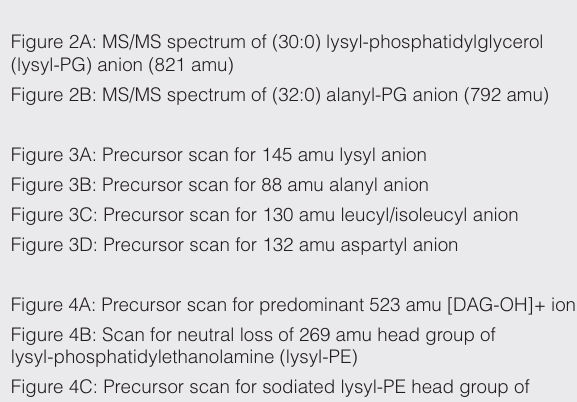
Figure 2A: MS/MS spectrum of (30:0) lysyl-phosphatidylglycerol (lysyl-PG) anion (821 amu) Figure 2B: MS/MS spectrum of (32:0) alanyl-PG anion (792 amu) Figure 3A: Precursor scan for 145 amu lysyl anion Figure 3B: Precursor scan for 88 amu alanyl anion Figure 3C: Precursor scan for 130 amu leucyl/isoleucyl anion Figure 3D: Precursor scan for 132 amu aspartyl anion Figure 4A: Precursor scan for predominant 523 amu [DAG-OH]+ ion Figure 4B: Scan for neutral loss of 269 amu head group of lysyl-phosphatidylethanolamine (lysyl-PE) Figure 4C: Precursor scan for sodiated lysyl-PE head group of 292 amu Figure 4D: Precursor scan for sodiated alanyl-PE head group of 235 amu Figure 5: MS/MS spectra of chemically synthesized (16:0-18:1) lysyl- and analyl-PE Figure 5A: MS/MS spectrum protonated (16:0-18:1) lysyl-PE (846 amu) Figure 5B: MS/MS spectrum of sodiated (16:0-18:1) lysyl-PE (868 amu) Figure 5C: MS/MS spectrum of protonated (16:0-18:1) alanyl-PE (789 amu) Figure 5D: MS/MS spectrum of sodiated (16:0-18:1) alanyl-PE (811 amu) Figure 6: High-accuracy MS/MS spectrum of (32:0) lysyl-PG (873 amu) Figure 7: High-accuracy MS/MS spectrum of (32:0) alanyl-PG (816 amu) Figure 9: Precursor scans for 88 amu alanyl anion and 266 amu sodiated alanyl-PG head